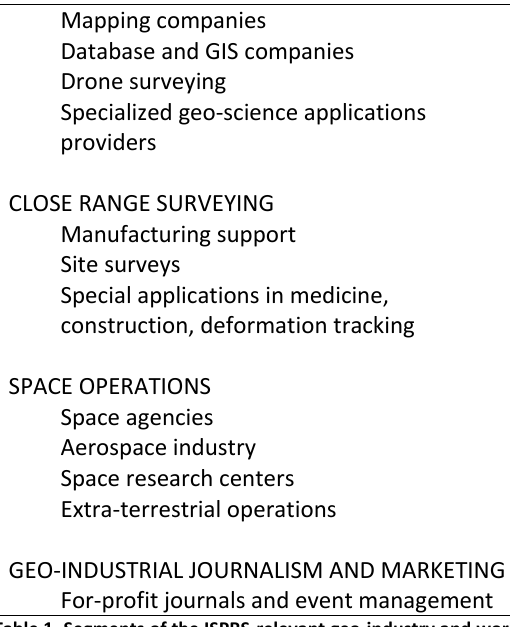
Table 1. Segments of the ISPRS-relevant geo-industry and world of business The data in Table 2 suggest that there is room for improvements in the interaction of the ISPRS with industry.